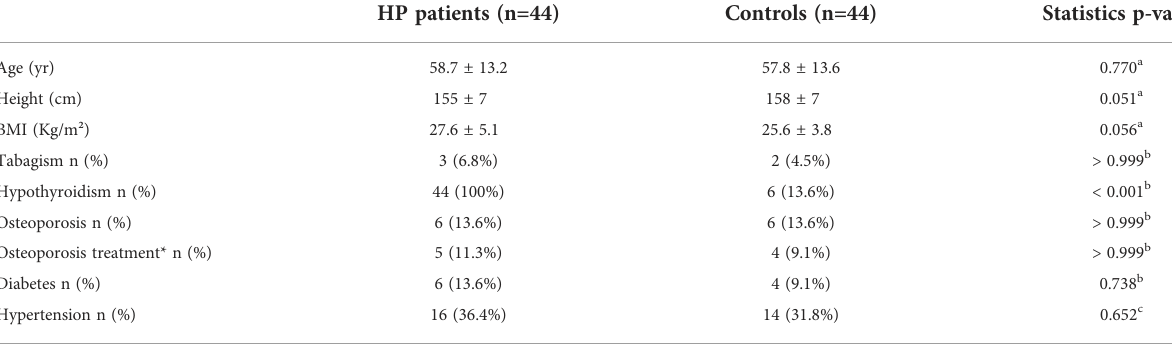
TABLE 2 Baseline clinical characteristics of patients with postsurgical hypoparathyroidism and